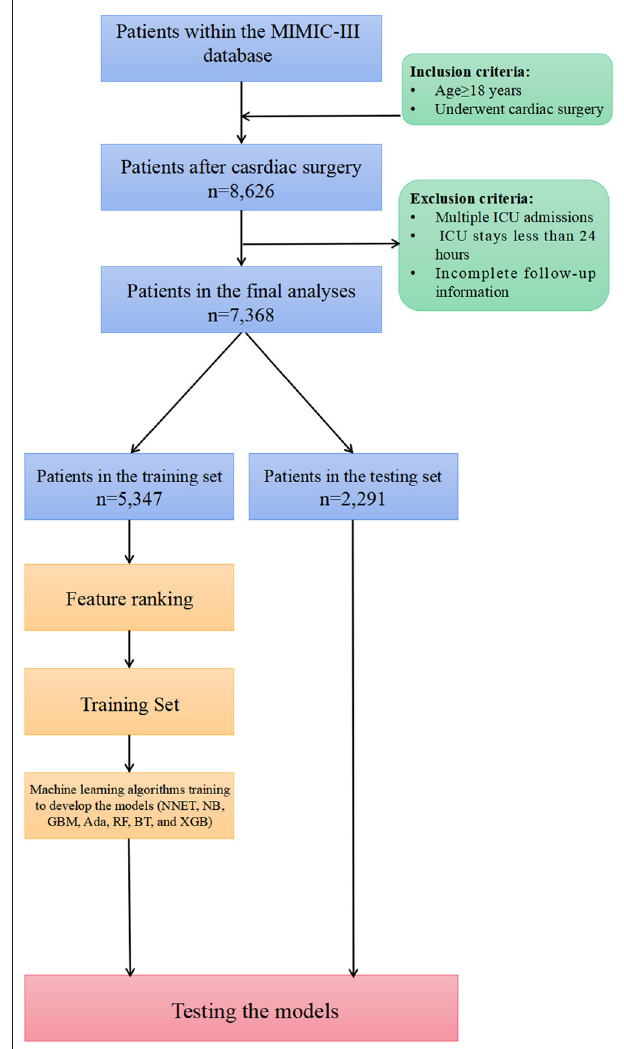
FIGURE 1 | Overview of the methods used for data extraction, training, and testing. MIMIC, Medical Information Mart for Intensive Care; ICU, intensive care units; NNET, artificial neural network; NB, naïve bayes; GBM, gradient boosting machine; Ada, adapting boosting; RF, random forest; BT, bagged trees; XGB, eXtreme Gradient Boosting; LR, logistic